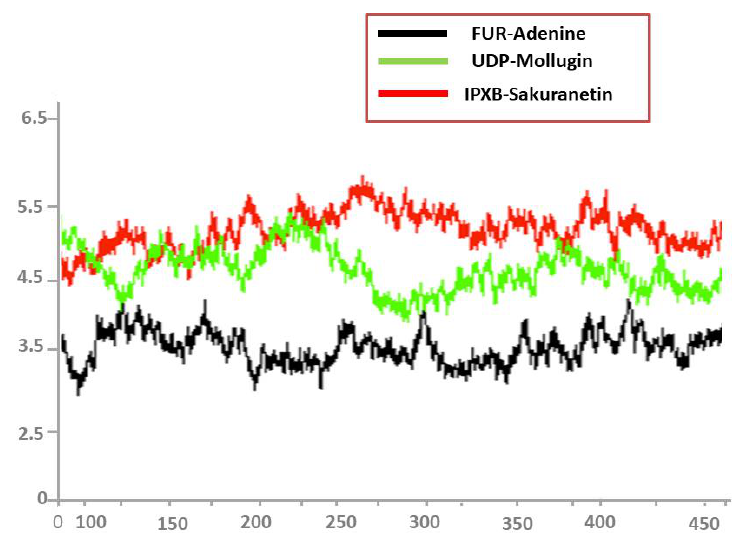
Figure 7. RMSF analysis of top docked